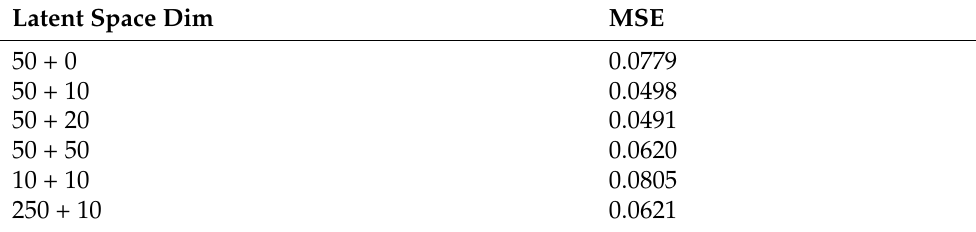
Table 3. Sensitivity analysis: latent space dimension. We report the reconstruction performance depending on the dimension of the latent space. Each configuration “ a + b ” refers to a a -dimensional output Z 1 of the encoder Ψ and a b-dimensional augmented component Z 2 to take account for unobserved dynamics.